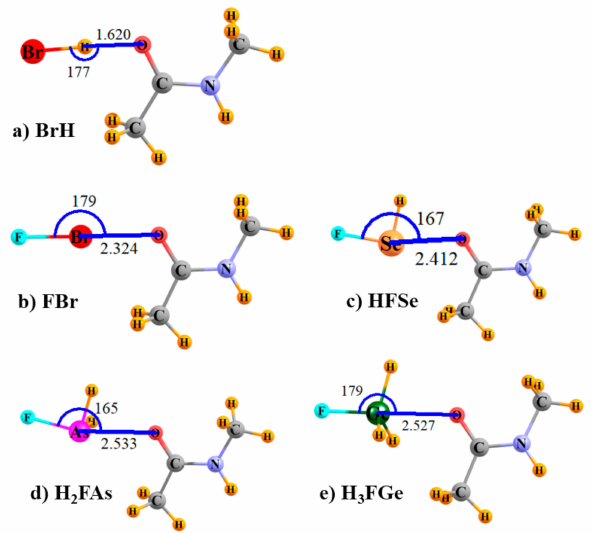
Figure 1. Optimized geometries of indicated Lewis acids with N-methylacetamide (NMA). Distances in Å, angles in